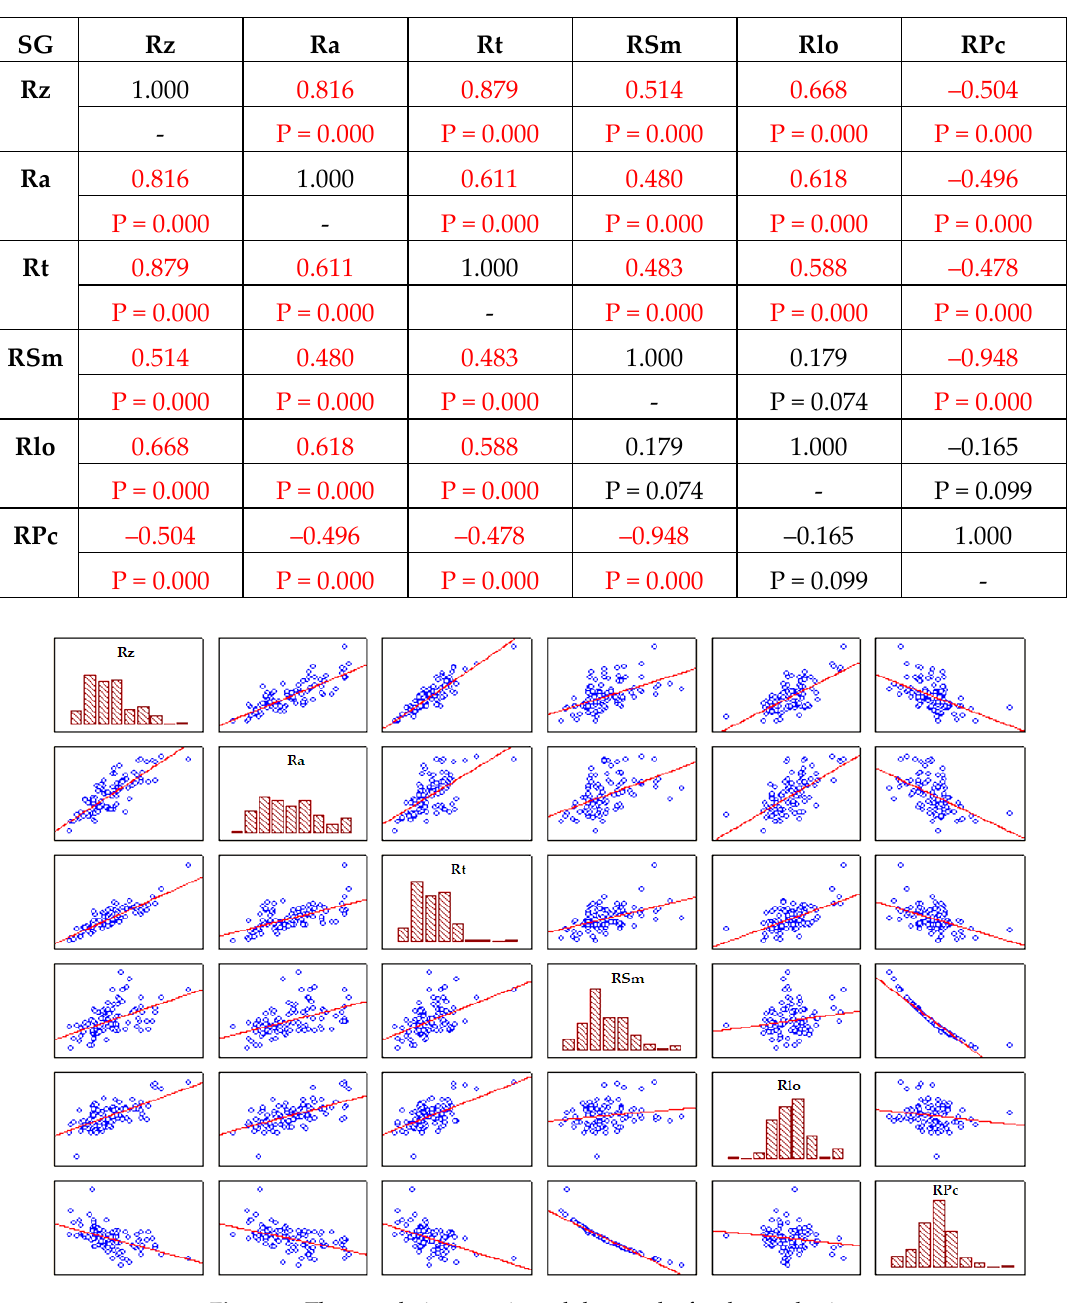
Figure 8. The correlation matrix and the graphs for the steel grit.